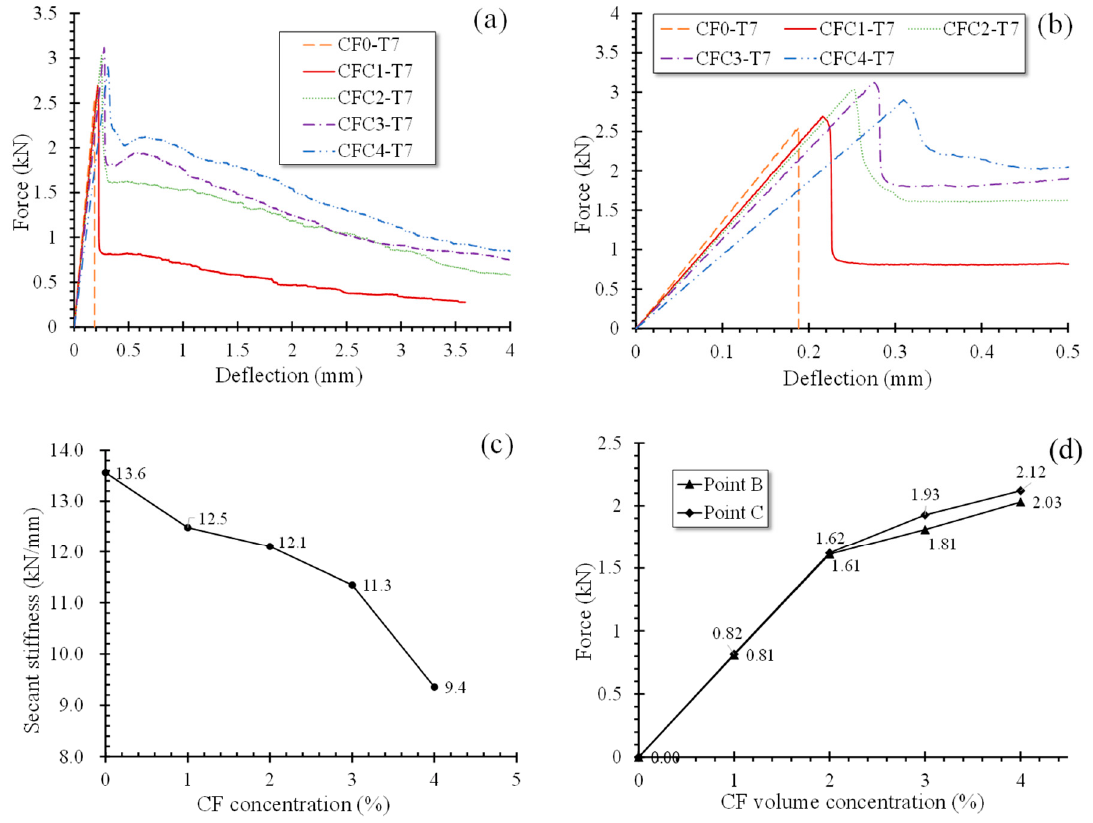
Figure 11. L-D curves and secant sti ff ness of group T7. ( a ) L-D curves; ( b ) enlarged view in O–A; ( c ) secant sti ff ness of O–A; ( d ) Loading force at point B and C.